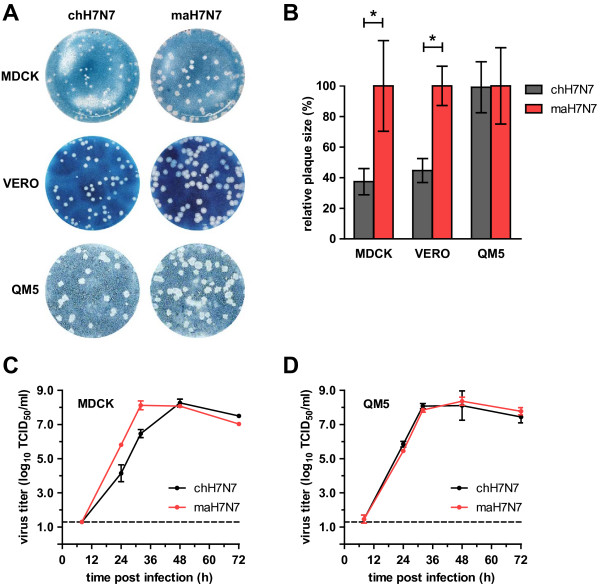
Growth of H7N7/03 viruses in cell culture. A) Plaque formation. MDCK, VERO or QM5 cells were infected with ~50 PFU of virus and stained with amido black after 7 days of incubation. B) Quantification of plaque size in MDCK, VERO and QM5 cells. The mean plaque size (measured in mm2) of chH7N7 is plotted relative to that of maH7N7 (set at 100%). Error bars represent the standard deviations. The asterisk indicates significant difference in mean plaque size (P < 0.05). C, D) Growth kinetics of H7N7/03 viruses. MDCK (C) or QM5 cells (D) were infected with chH7N7 or maH7N7 virus at an m.o.i. of 0.001 TCID50 per cell. Culture supernatants were harvested at 8, 24, 32, 48 and 72 h p.i. and virus titers were determined by end-point titration in MDCK cells. Shown are means from duplicate experiments with error bars indicating standard deviations. The dotted line indicates the lower limit of virus detection. Undetectable titers were assigned a value of 1.3.